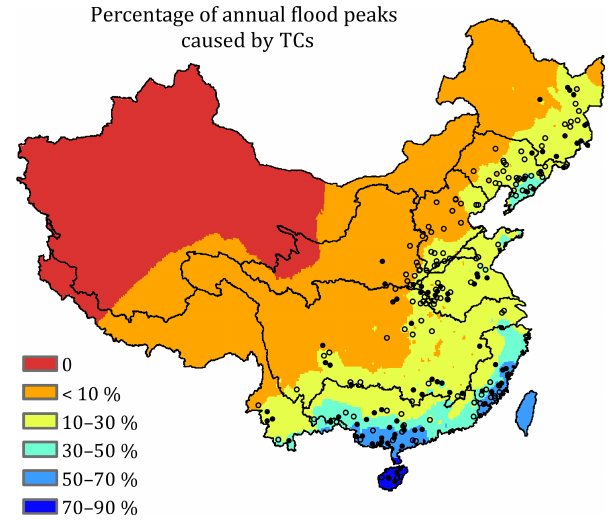
Figure 9. Percentage of annual flood peaks that are caused by trop- ical cyclones. The black dots and circles represent the stations with record floods caused by tropical cyclones. The black dots further highlight stations with stationary time series of annual flood peaks. In this figure, TC is used an abbreviation for tropical